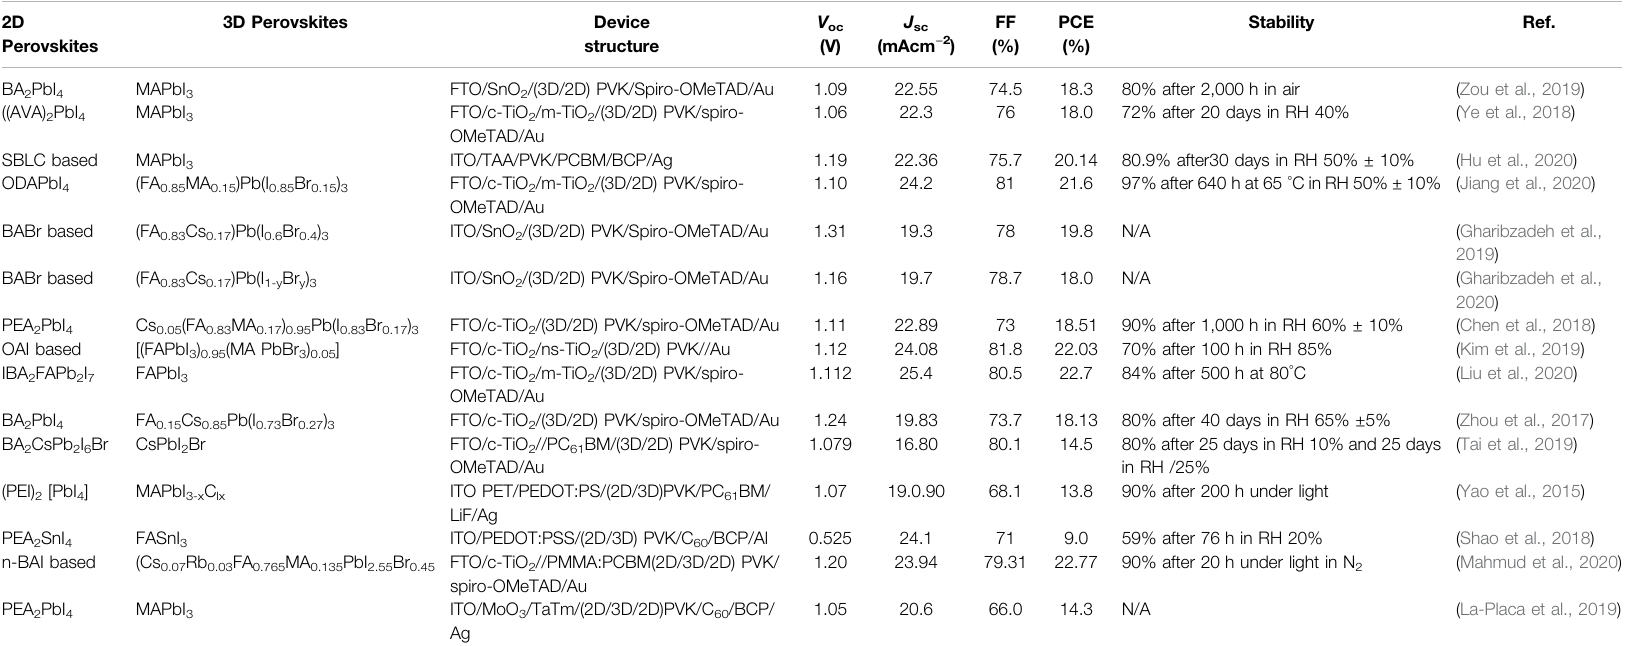
TABLE 2 | Photovoltaic performance and stability summary of representative layered 2D/3D multidimensional perovskite solar cells 2D